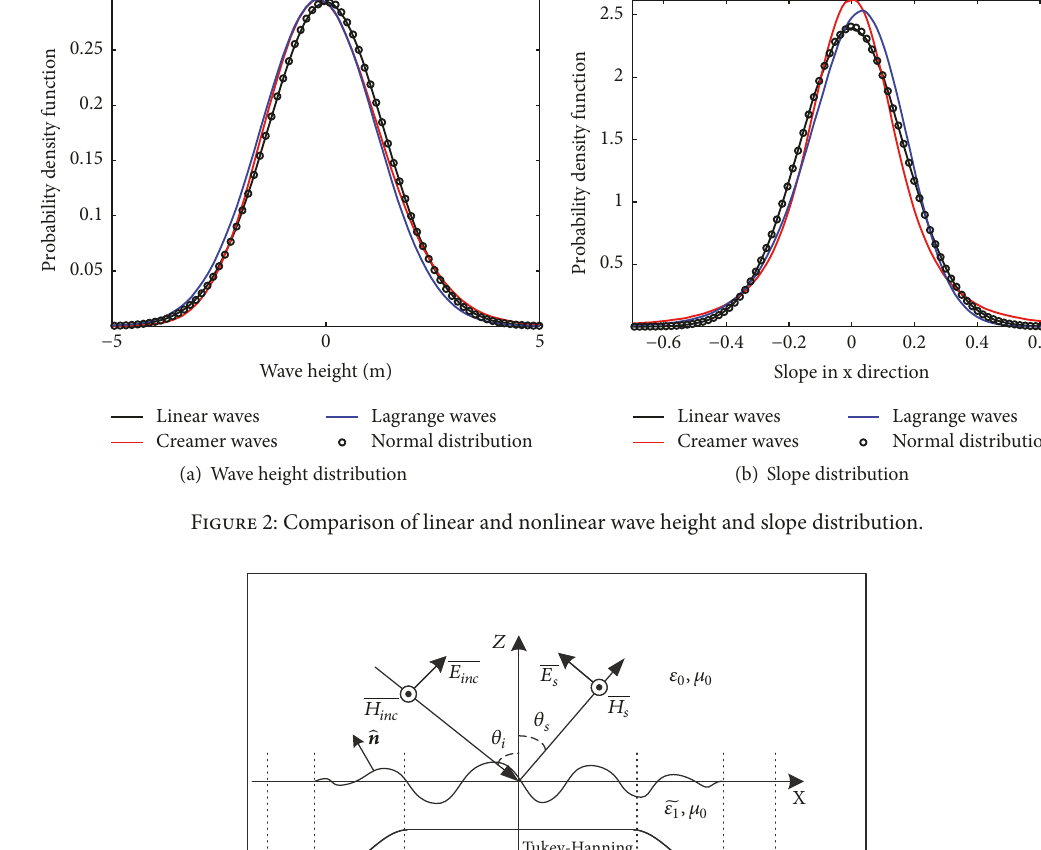
Figure 3: Geometry of the scattering problem and the locally perturbed